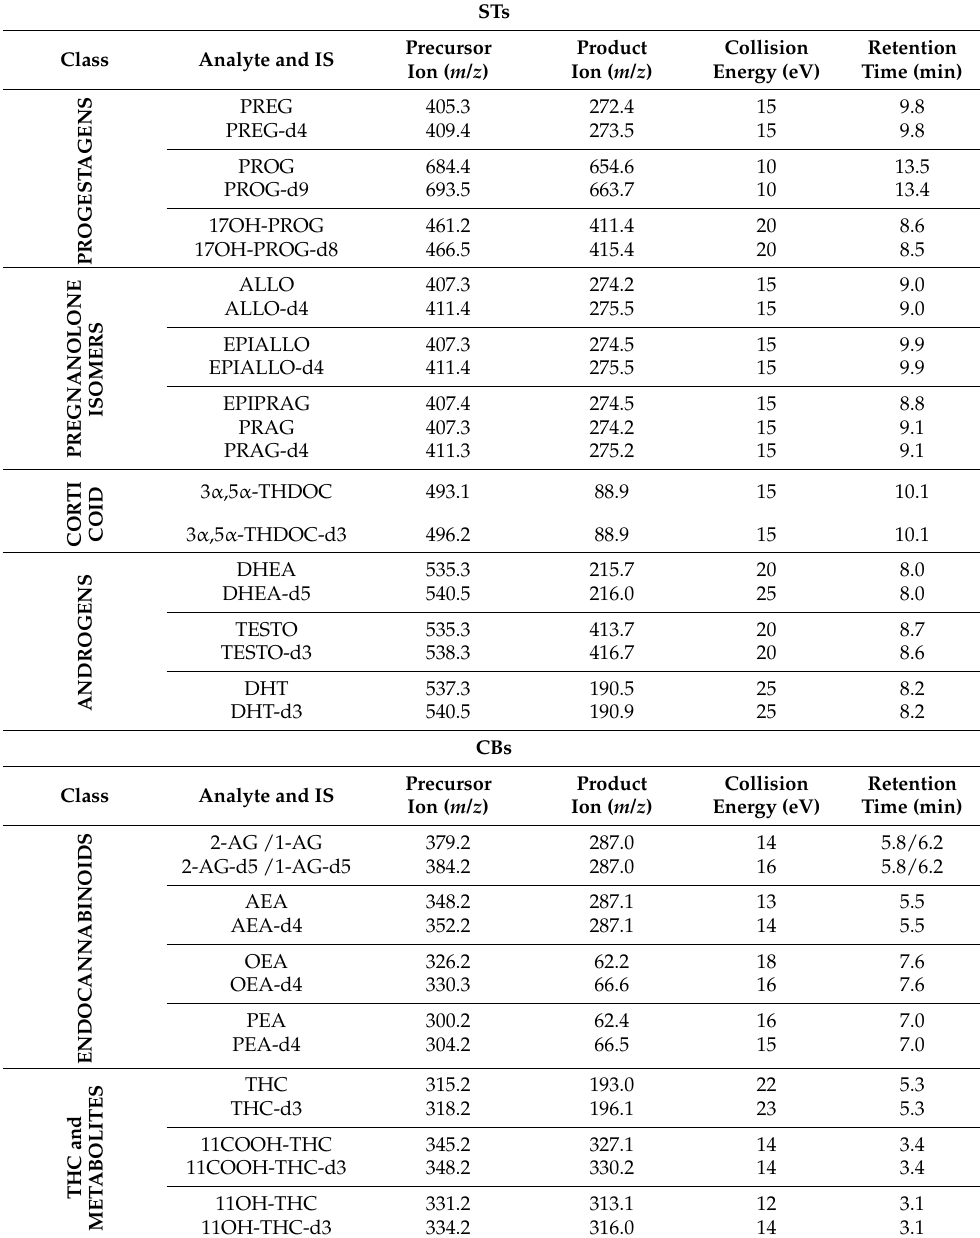
Table 2. Precursor ion, product ion, collision energy (eV), and retention time of each analyte and IS of STs (scan time 0.1s, dwell time 1 ms, scan width 0.8) and of CBs (scan time 0.1 s; dwell time 2 ms, scan width